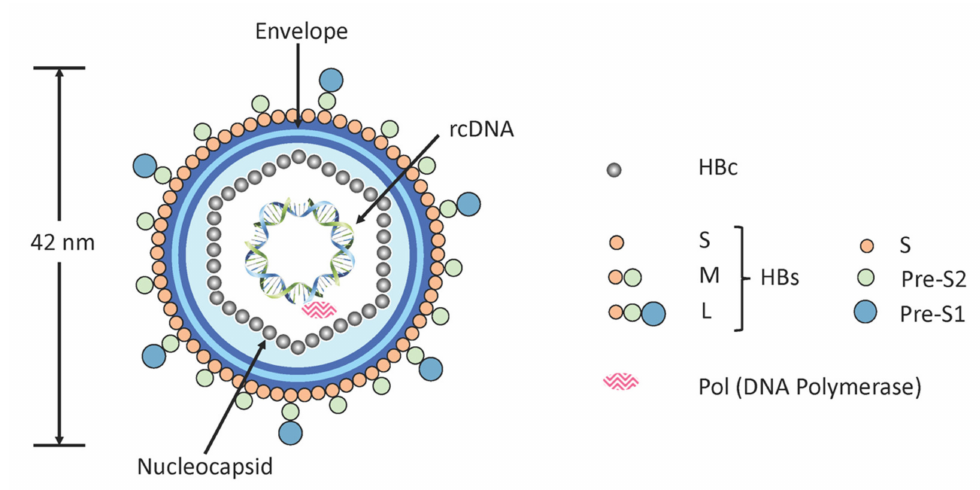
Figure 1. Schematic diagram of a HBV particle. The illustrated HBV infectious virion has the indicated main features as labelled with dimensions as